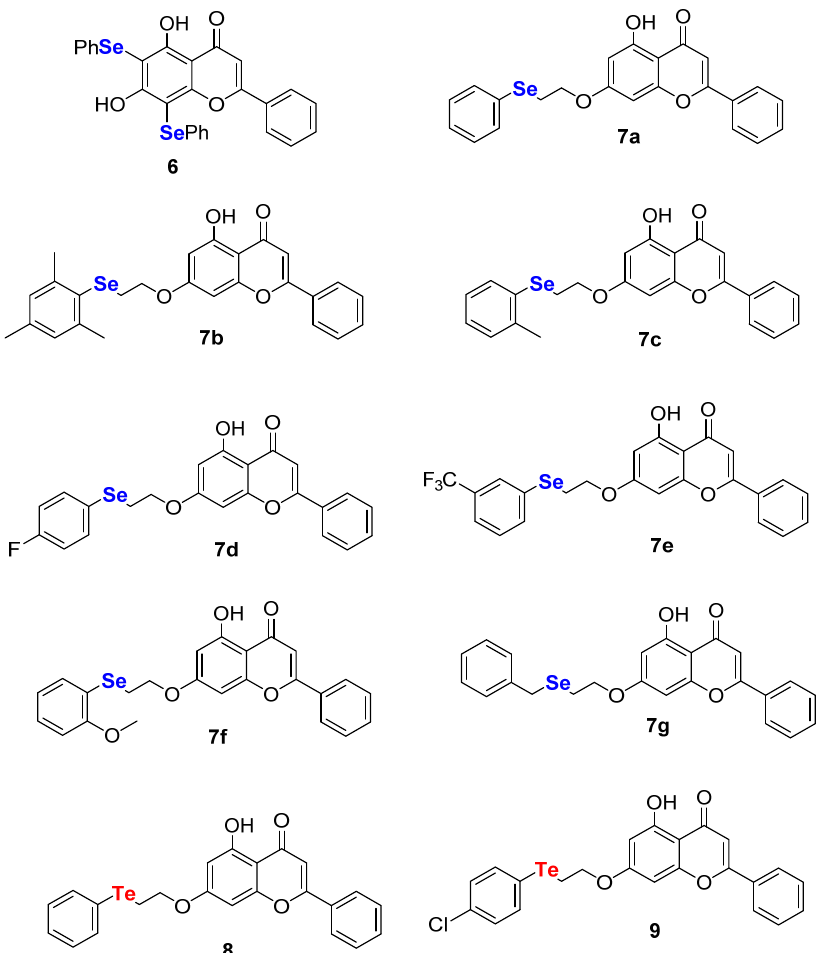
Figure 3. Chalcogen-containing chrysin derivatives.